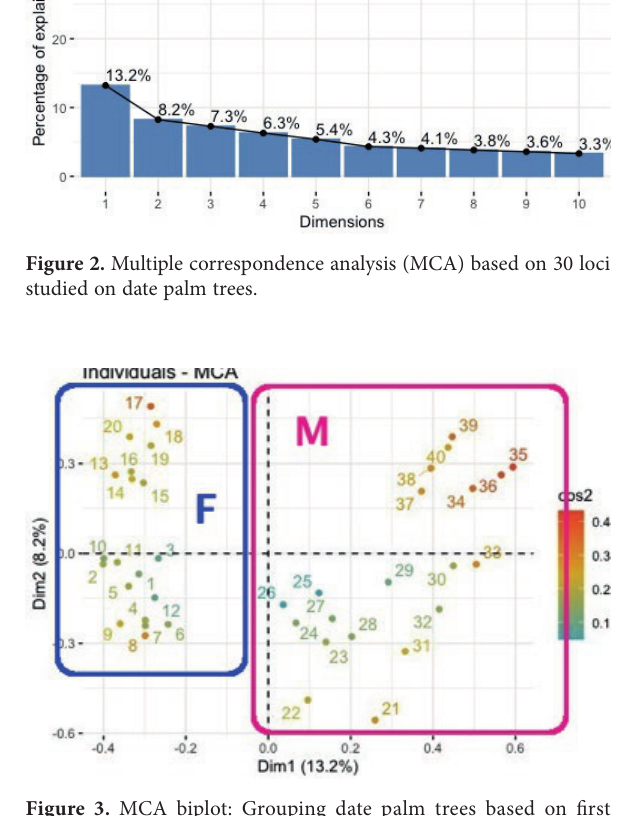
Figure 3. MCA biplot: Grouping date palm trees based on first two components. Numbers are individuals. Color gradient shows amount of variance based on MCAfrom high to low. M; male trees and F: female trees studied.